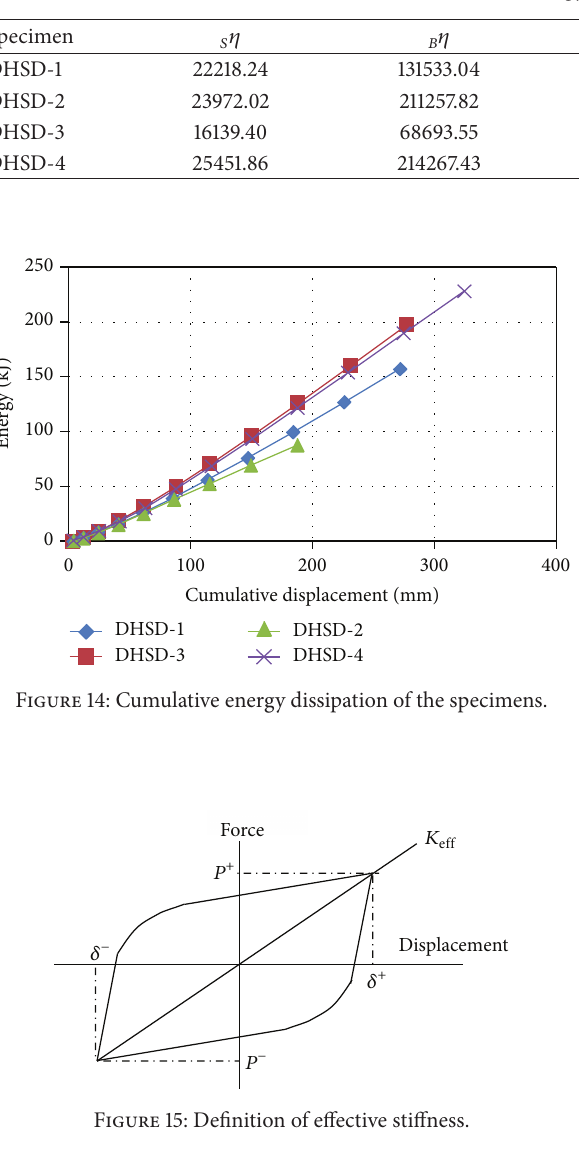
Table 3: Energy dissipation capacity.